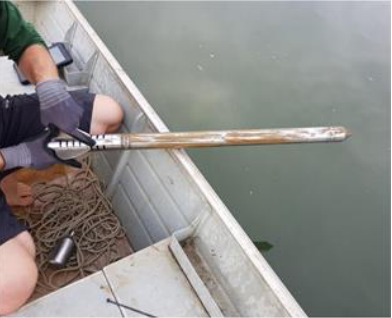
Figure 9. Picture of GraviProbe (GP) after deployment. Figure 8. Picture of GraviProbe (GP) after deployment. Figure 8. Picture of GraviProbe (GP) after deployment.